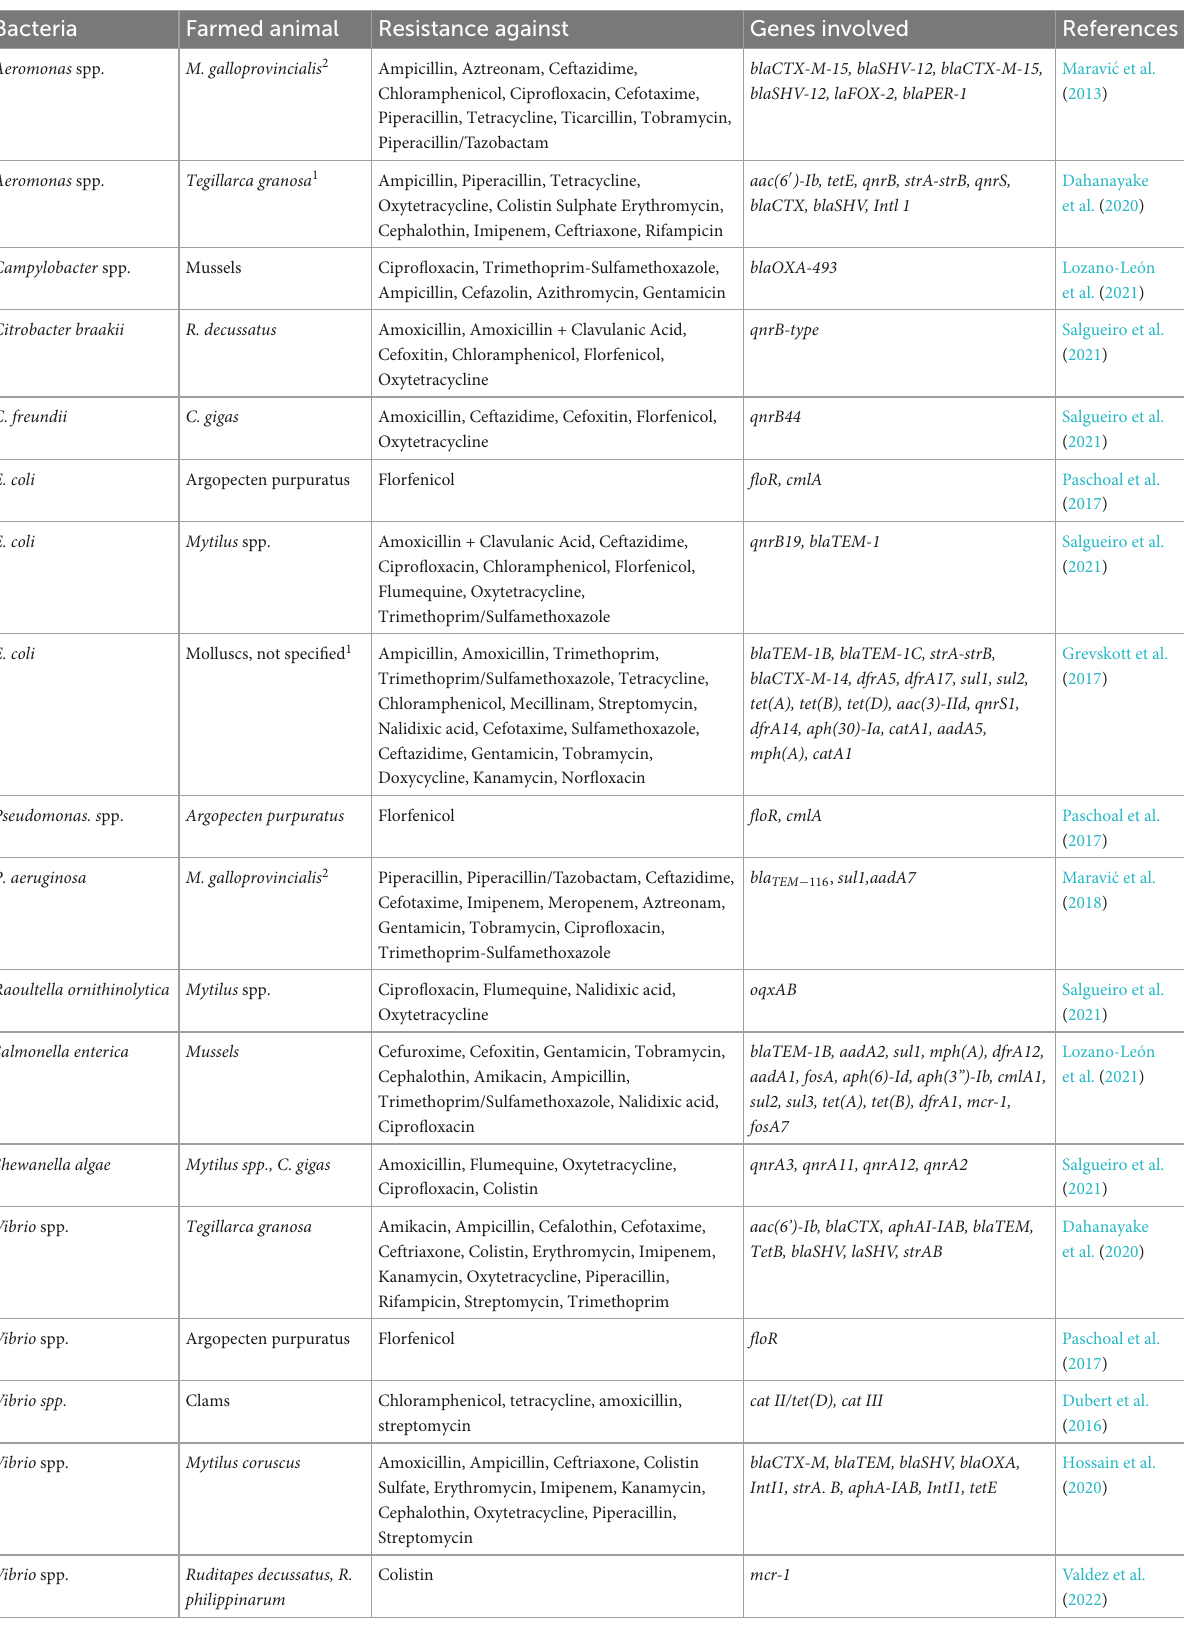
TABLE 2 Antibiotic resistance in bivalve aquaculture.